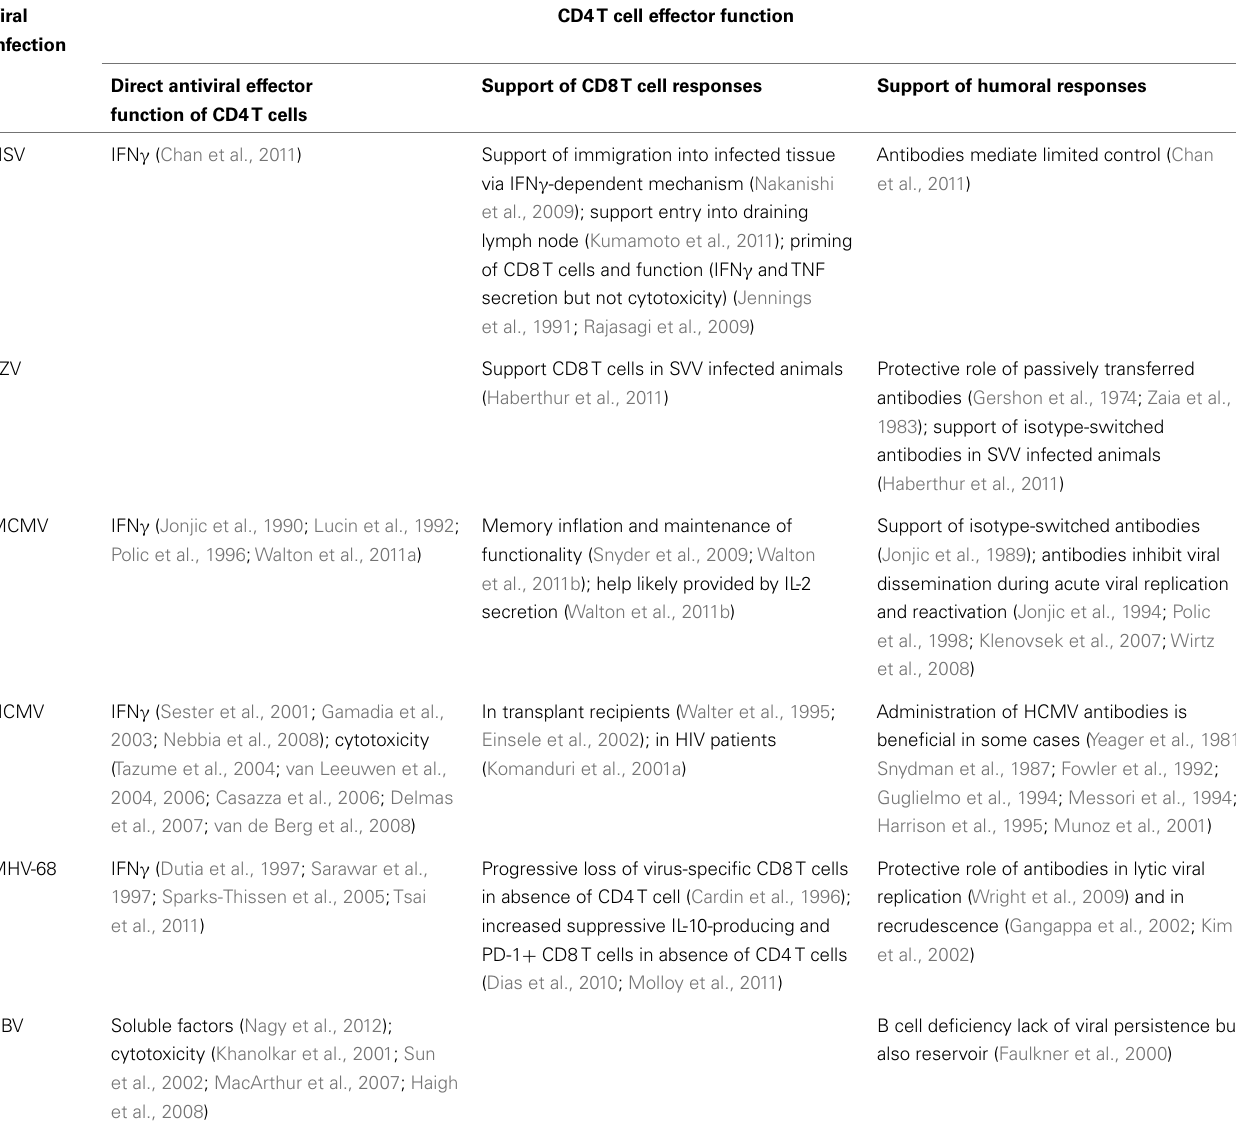
Table 2 | CD4T cell effector functions in herpes viral